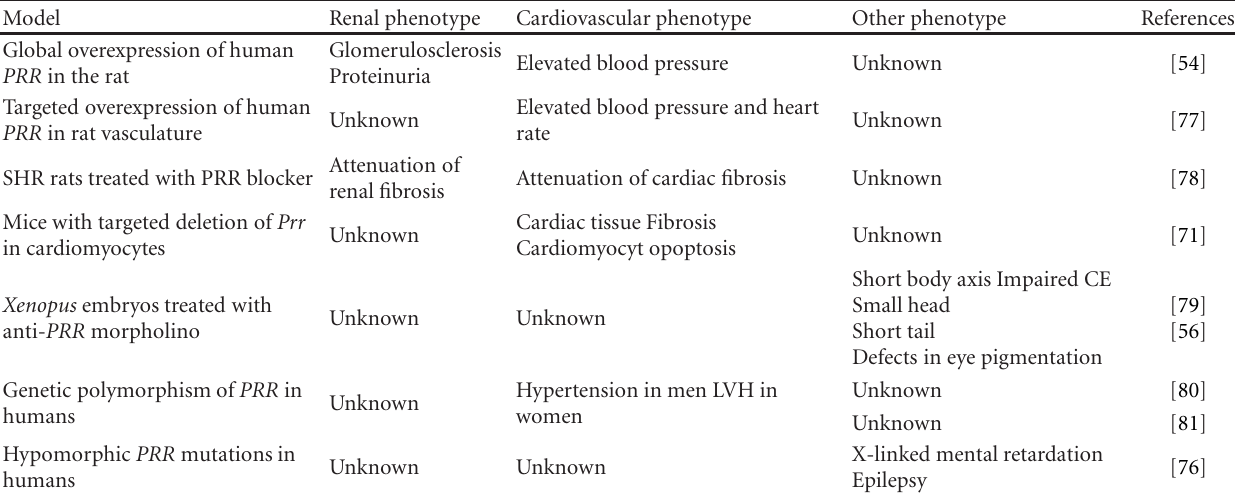
Table 1: Role of (pro)renin receptor (PRR) signaling in kidney development and